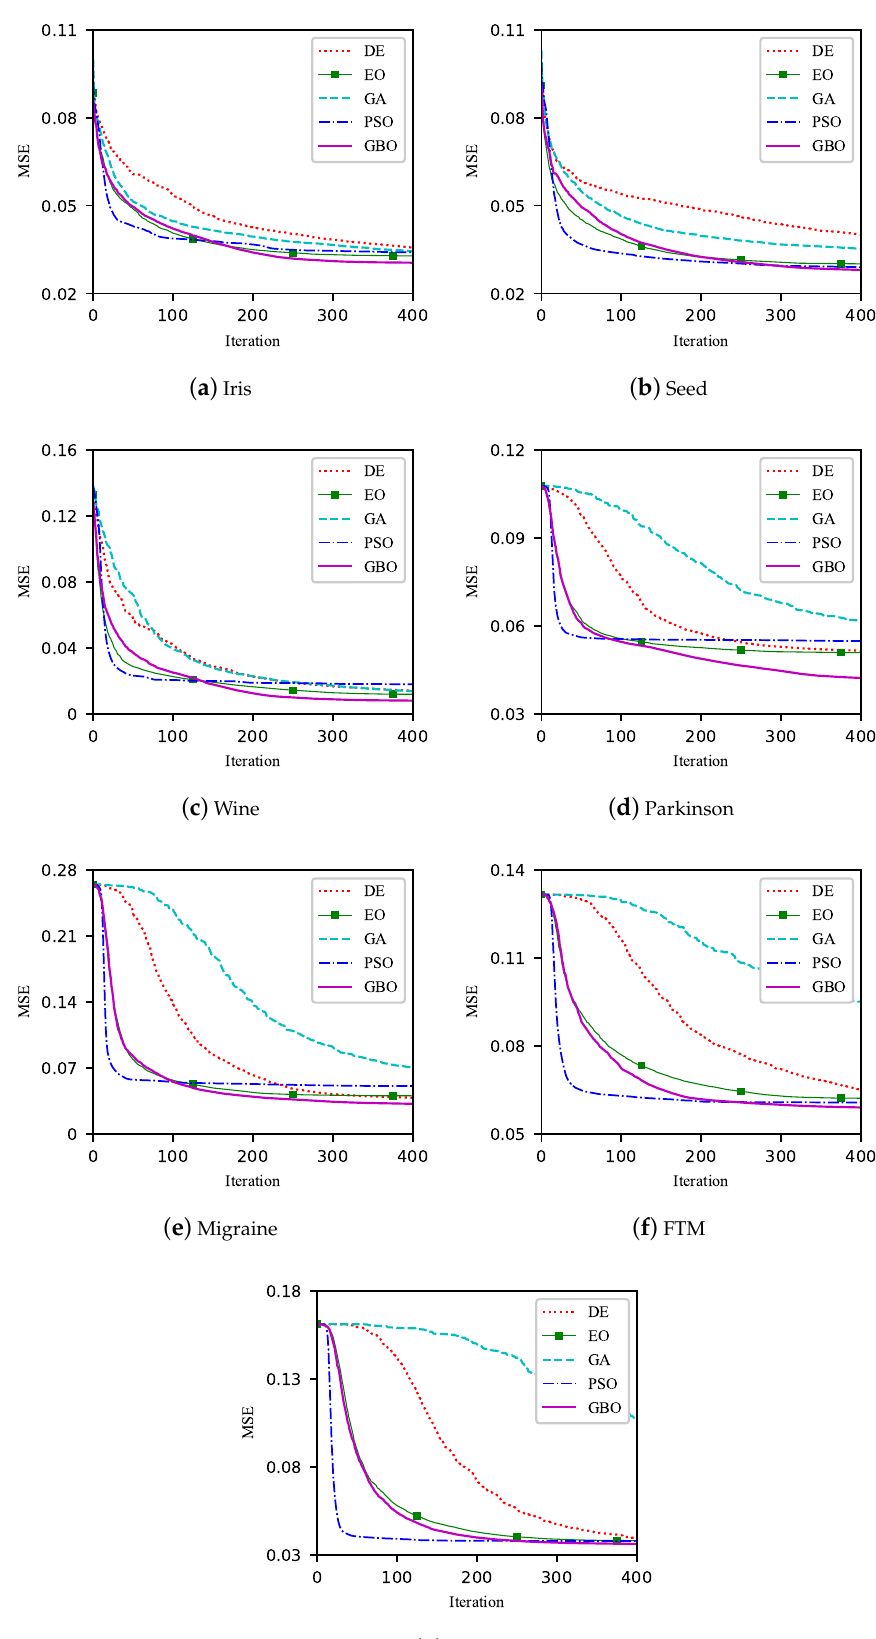
Figure 6. Convergence curves of five heuristic algorithms for training